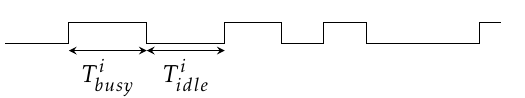
Figure 1. Channel model of idle & busy